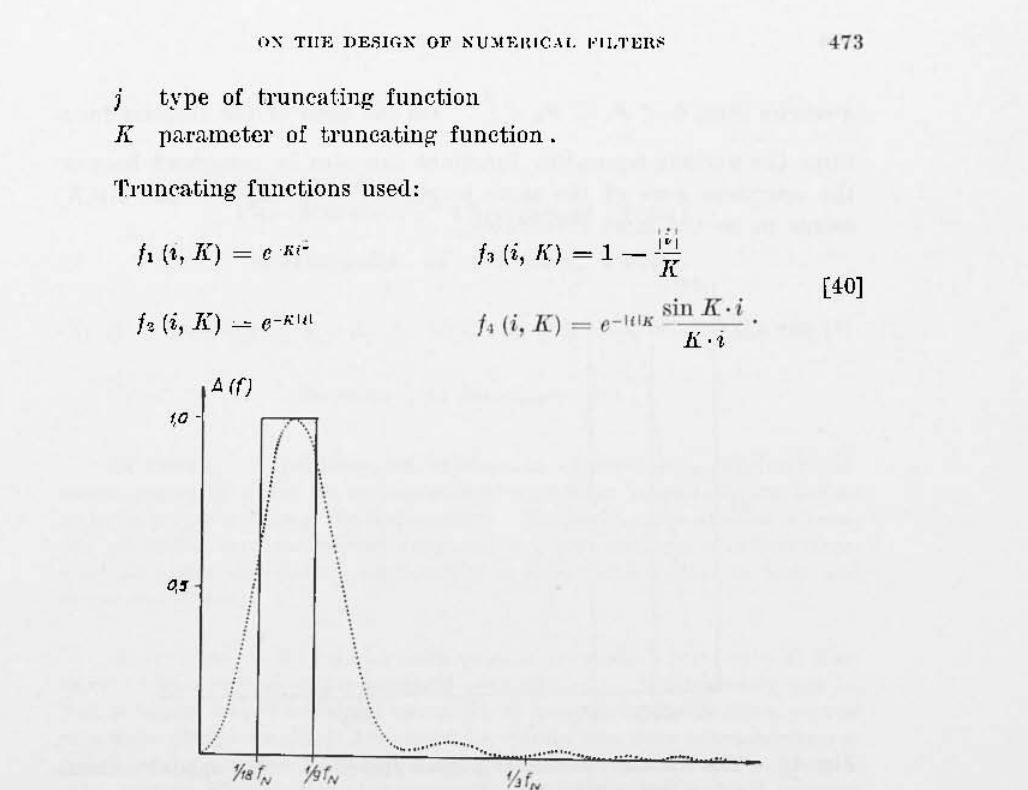
Fig. Il - '['ha transfar hmction of a banll pass fllter. The applisd trullc· atin,U: functioll i" 14 (i; ll). The interval of tha pass hallli